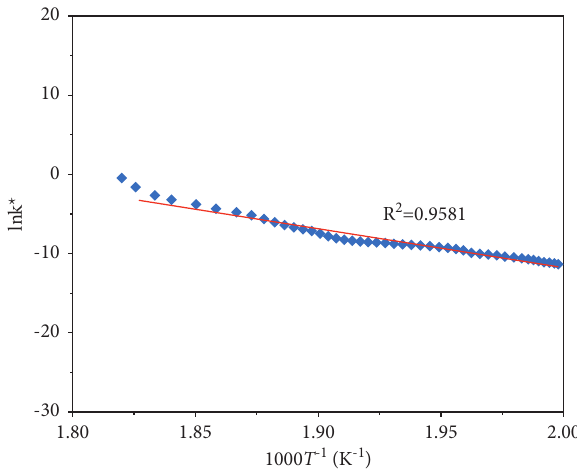
Figure 8: ln k vs. 1000/ T curve for Grignard reagent.